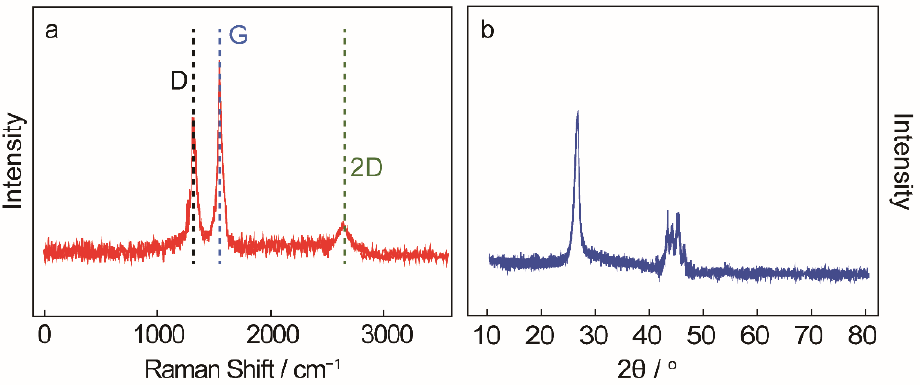
Figure 6. ( a ) Raman spectrum of cellular porous carbon. ( b ) XRD of cellular porous